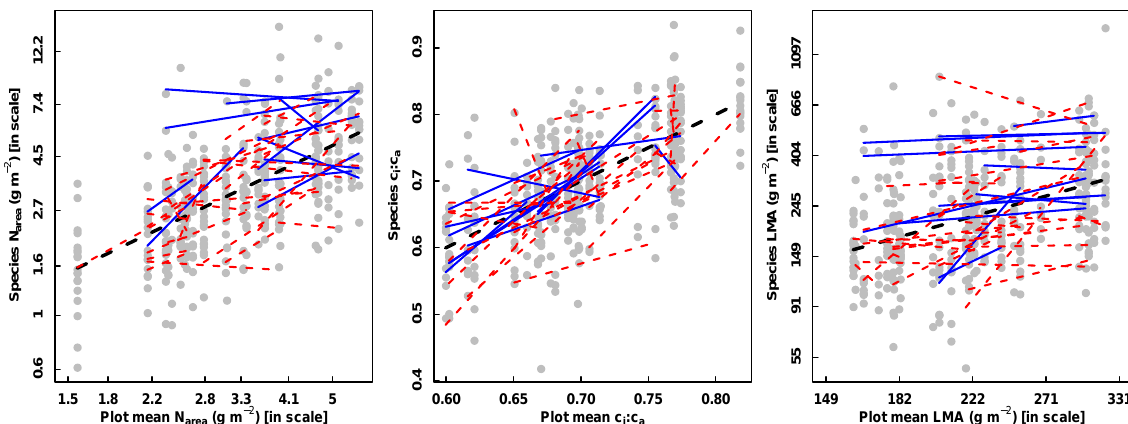
Figure 4. Trait means and regression lines for all 243 C 3 plant species in the 27 study sites. Note the logarithmic scales for N area (gm − 2 ) and LMA (gm − 2 ) . Thin red dashed lines represent individual within-species regression lines of non-N-fixer species. Thin blue lines represent individual within-species regression lines of N-fixer species. The black dashed line represents the overall regression line, which has a slope of unity by definition. Grey dots denote individual species–site combinations. Common within-species slopes are 0.53 ± 0.11 (ln N area ) , 1.02 ± 0.12 ( c i : c a ) , and 0.55 ± 0.11 (ln LMA). Table 3. Linear regression coefficients for N area as a function of independently predicted values of N rubisco and N structure (all in gm − 2 ) at species level. Estimated Predicted p Relative R 2 importance N rubsico 9.5 ± 2.0 6–20 <0.001 39% N structure 1.2 ± 0.2 1 <0.001 61% 52% N structure : “N-fixer” 1.0 ± 0.3 n/a <0.01 n/a n/a: not